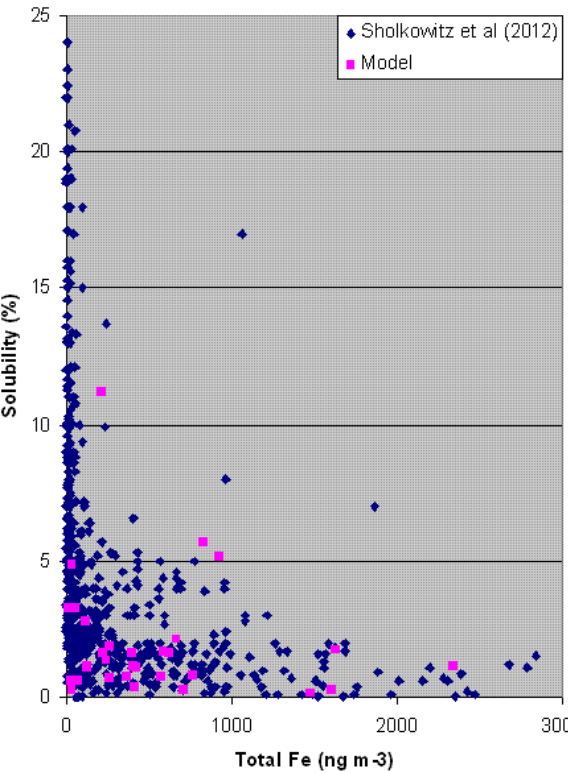
Figure 5. Fe solubility versus total Fe for the Atlantic sites/cruises. The plotted two groups of data: Fig. 5. Fe solubility versus total Fe for the Atlantic sites/cruises. The blue diamonds are from data sets 15, 16, 17, 18, 21, 22, 23 and data of Powell and Baker, as shown in Sholkovitz et al., (2012; Figure 5B); pink squares are simulated values plotted two groups of data: blue diamonds are from datasets 15, 16, 17, 18, 21, 22, 23 and unpublished data of Powell and Baker, as shown in Sholkovitz et al. (2012; Fig. 5b); pink squares are simu- lated values.